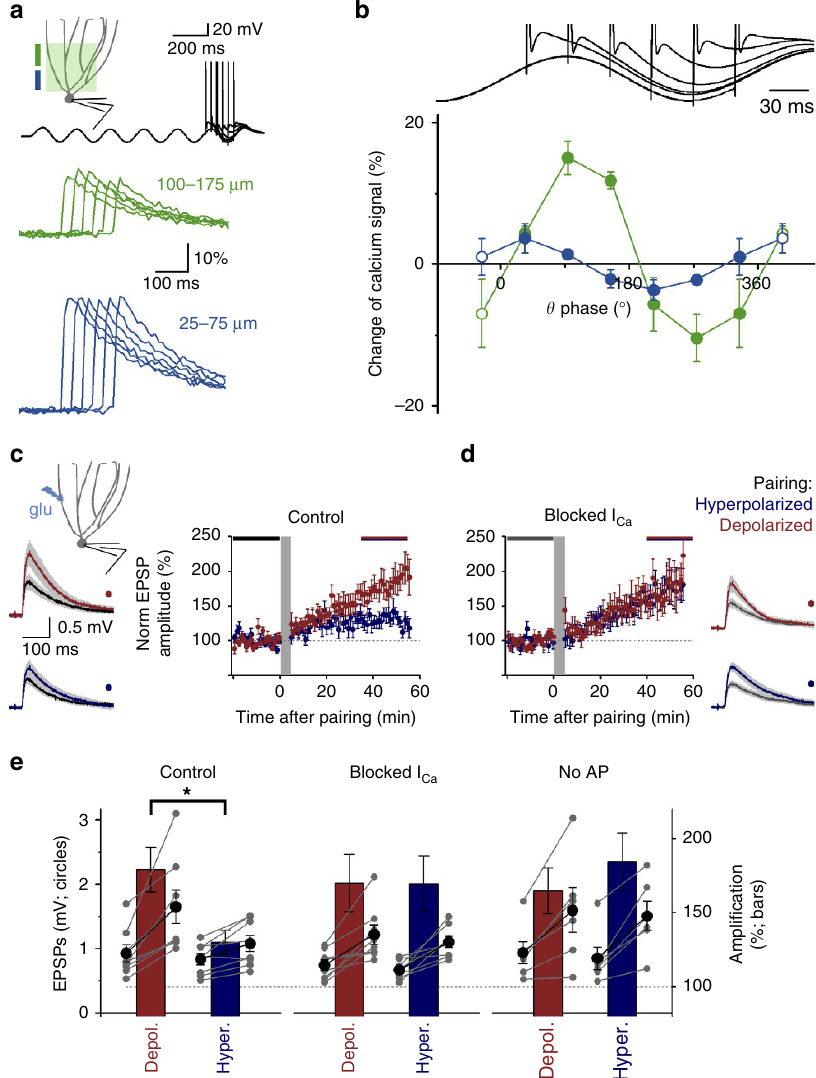
Figure 6 | Physiological impacts of the analogue content of the hybrid dendritic bAPs. ( a ) Average calcium signals evoked by single APs, which were preceded by five sine waves in the theta range (5.2Hz). ( b ) Changes of the bAP-evoked calcium signal amplitudes during the theta cycle relative to rest at proximal (light blue) and distal (green) regions. For better visualization, the first and last data points in the theta cycle are shown after and before the actual data (open symbols). See also Supplementary Fig. 4. ( c ) Average traces ( n ¼ 8 and 8 cells) before and after pairing of glutamate uncaging-evoked distal EPSPs (150–200 m m) with postsynaptic APs (300 pairing at 1Hz, timing ± 4ms; Supplementary Fig. 13). The pairing was made either at depolarized (red, (cid:2) 62.5 ± 0.5mV) or hyperpolarized (blue, (cid:2) 81.4 ± 0.5mV) membrane potentials. The graph shows the differential long-term changes of EPSP amplitudes depending on the pairing membrane potential ( n ¼ 8 and 8 cells). ( d ) Same experimental arrangement as in c except that calcium channels were blocked with Ni 2 þ , nifedipine, NNC55-0396 and o -conotoxin ( n ¼ 8 and 8 cells at (cid:2) 62.3 ± 0.2 and (cid:2) 81.1 ± 0.4mV, respectively). ( e ) Summary of the long-term changes in control conditions, with inhibited calcium channels and using a pairing protocol that lacks postsynaptic firing ( n ¼ 8, 8, 8, 8, 6 and 6, respectively, at hyper- and depolarized pairing protocols). Bars show the average relative effects of pairing at the two membrane potentials in the three conditions (right axis, P ¼ 0.013, P ¼ 0.99, P ¼ 0.45, respectively, t -test, averages of the 30–50min period after pairing) and circles indicate the absolute EPSP amplitudes before and after pairing (left